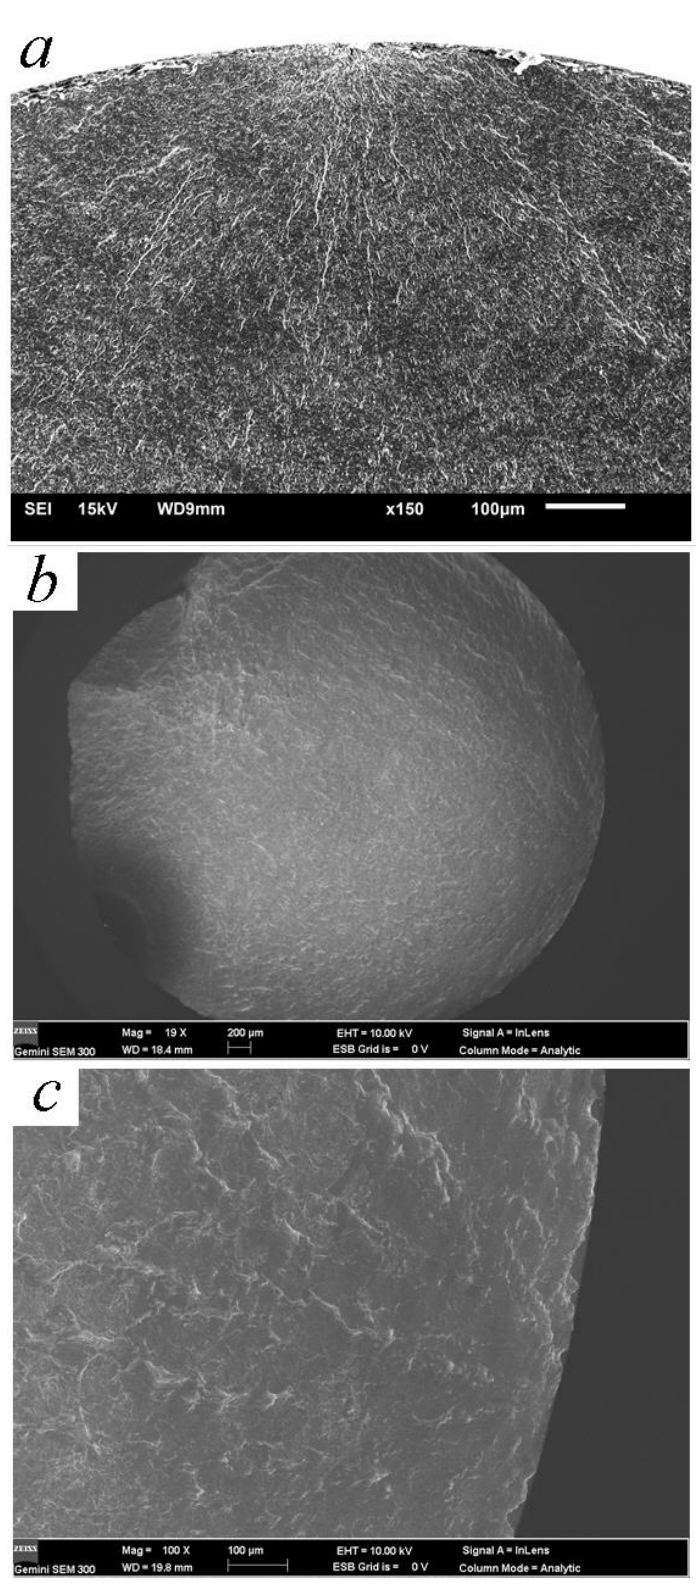
Figure 7. Surface cracks of TC4 and TLM: ( a ) TC4-ultrasonic impact (UI), 730 MPa, 2.49 × 10 5 cycles; ( b ) TLM-UI, 550 MPa, 1.07 × 10 6 cycles; ( c ) magnification of the crack initiation of Figure 7b.